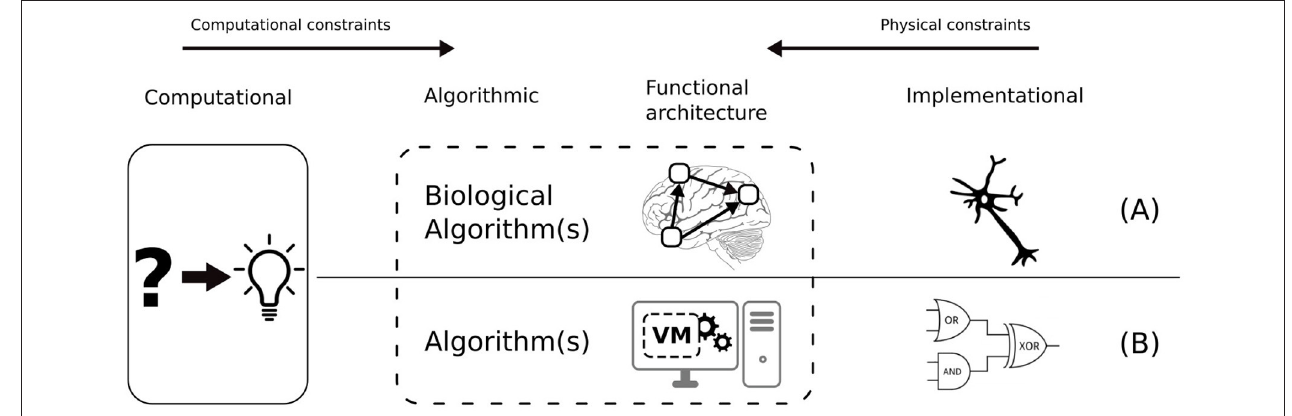
FIGURE 1 | Marr’s three levels of analysis: Computational, Algorithmic, and Implementational from a biological (A) and artificial (B) perspective. Also, the functional architecture: the basic functions of the functional architecture cannot be decomposed further without considering implementational